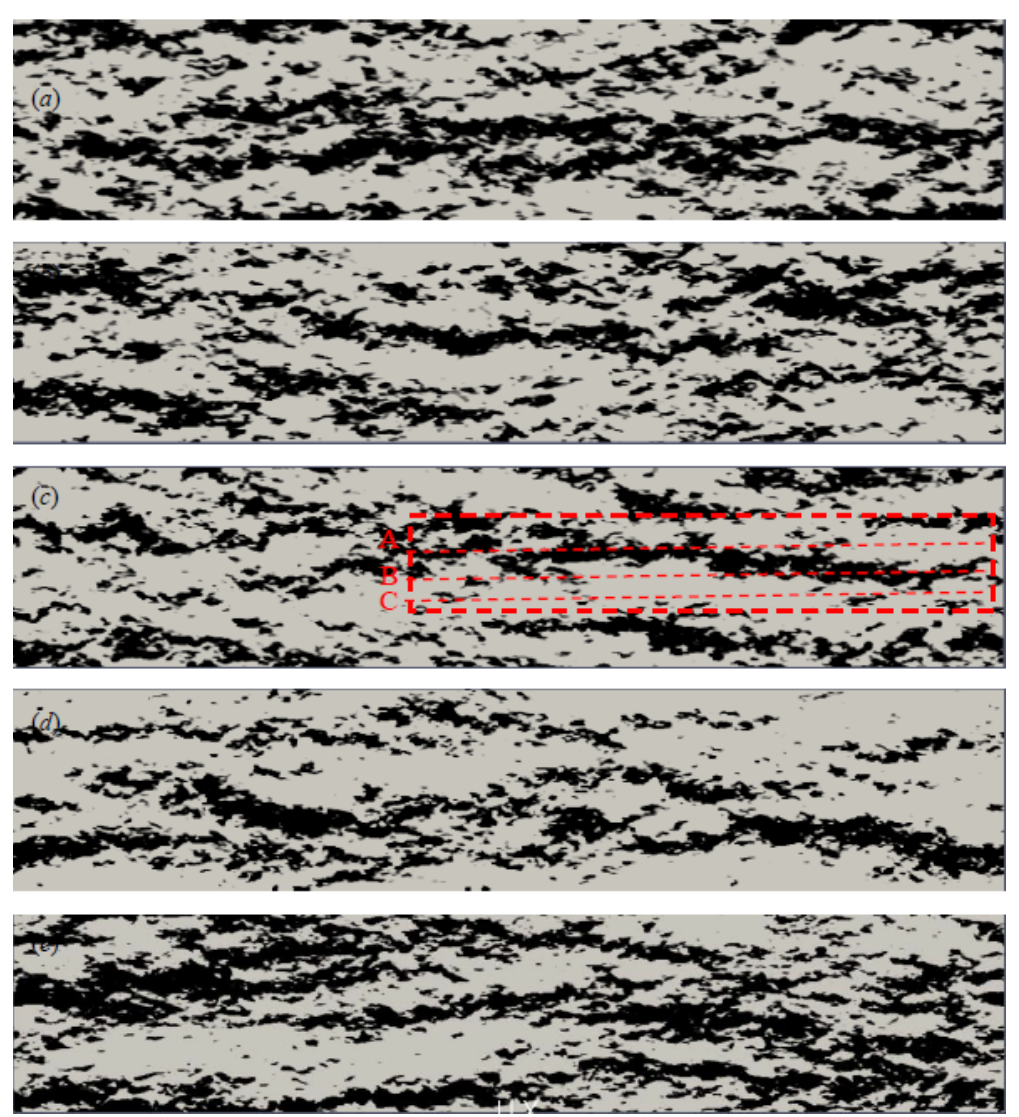
Figure 16. The normalized streamwise velocity fluctuations in xy plane. ( a ) case-1, ( b ) case-2, ( c ) case-3, ( d ) case-4, ( e ) case-5.